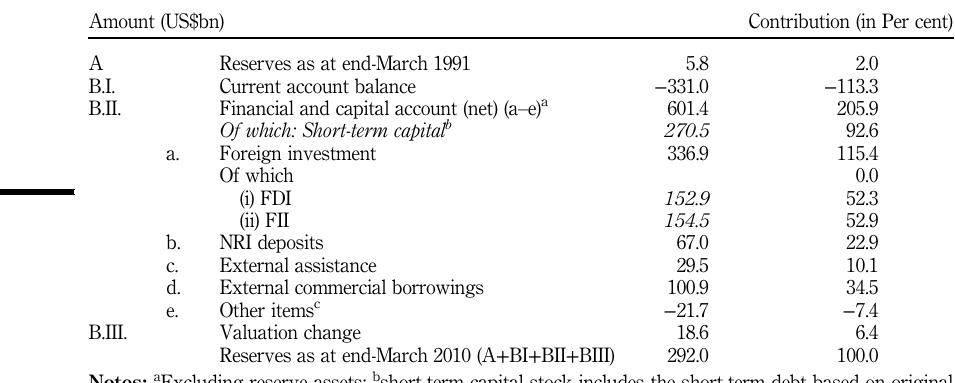
Table II. Sources of accretion